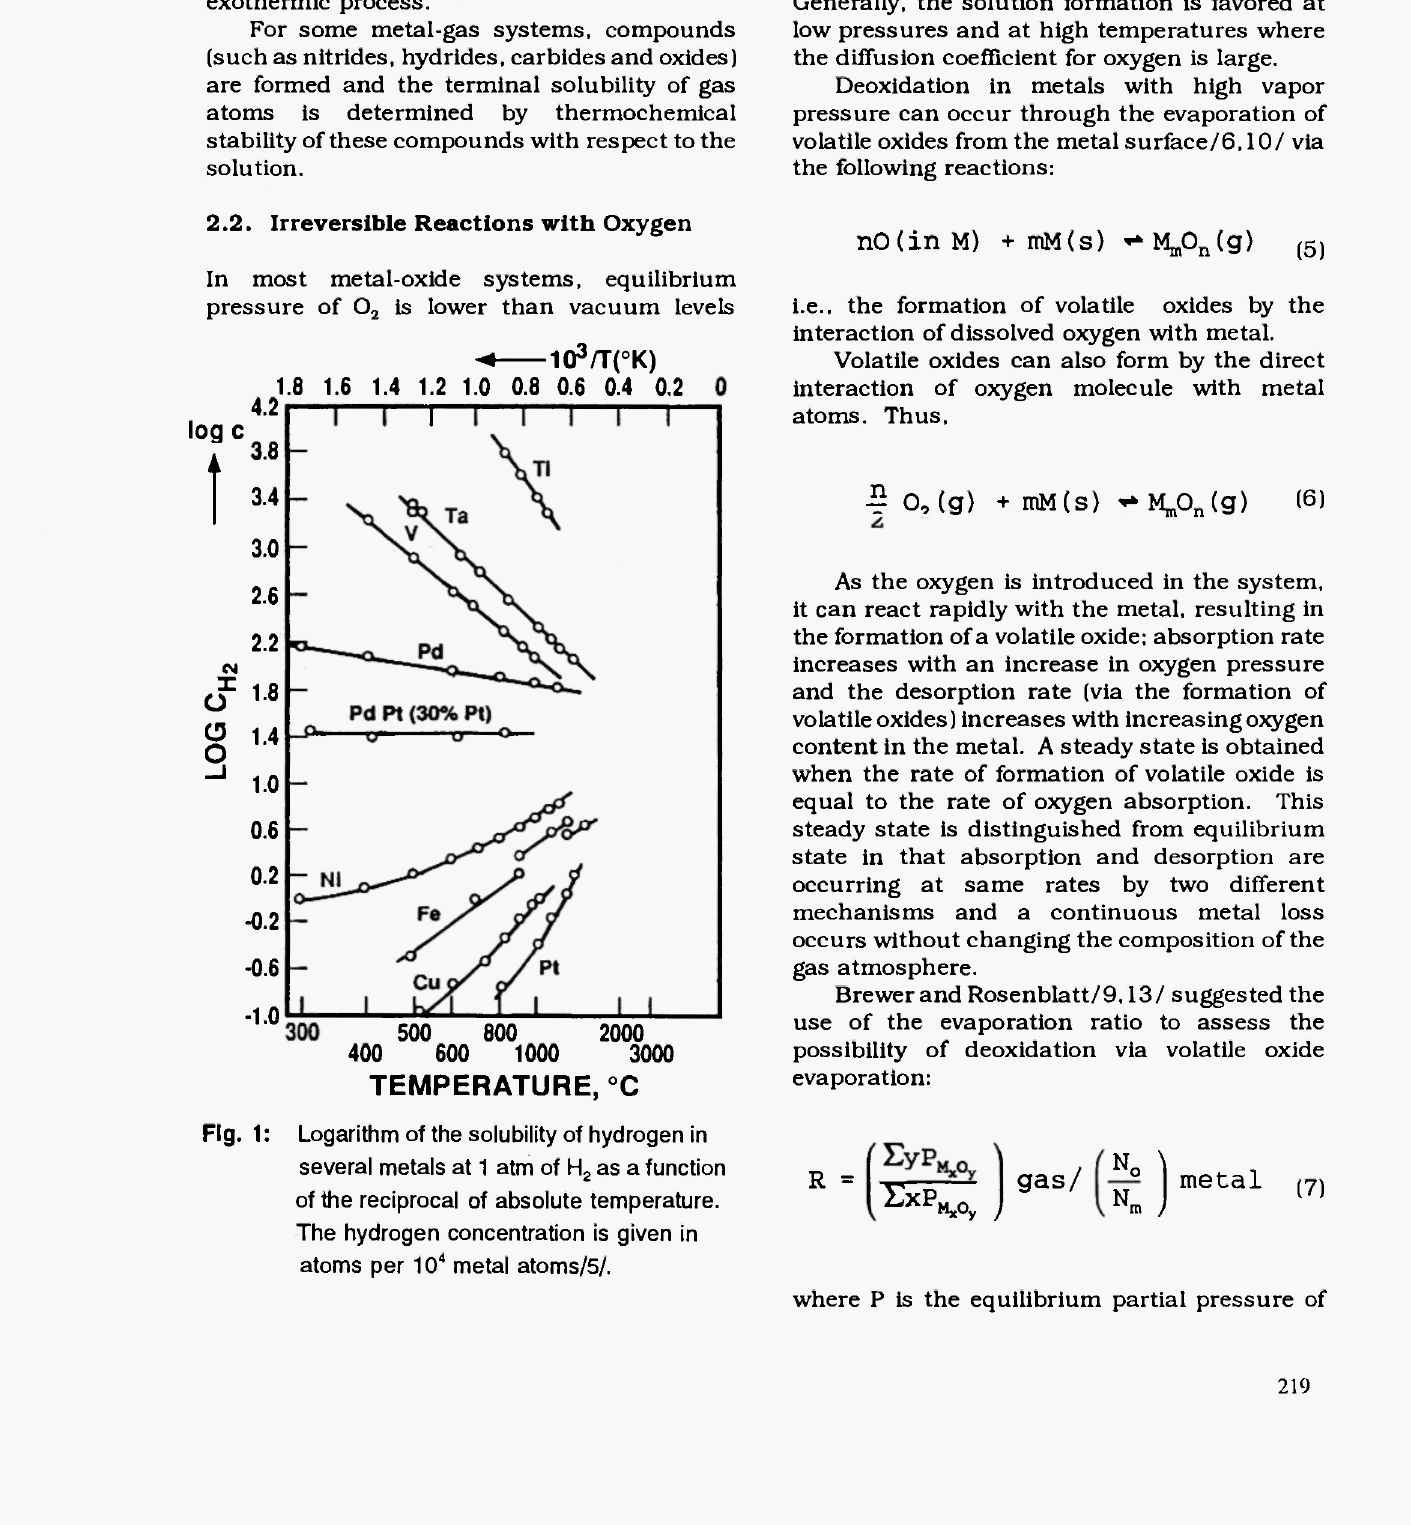
TEMPERATURE, °C Fig. 1: Logarithm of the solubility of hydrogen in several metals at 1 atm of H 2 as a function of the reciprocal of absolute temperature. The hydrogen concentration is given in atoms per 10 4 metal